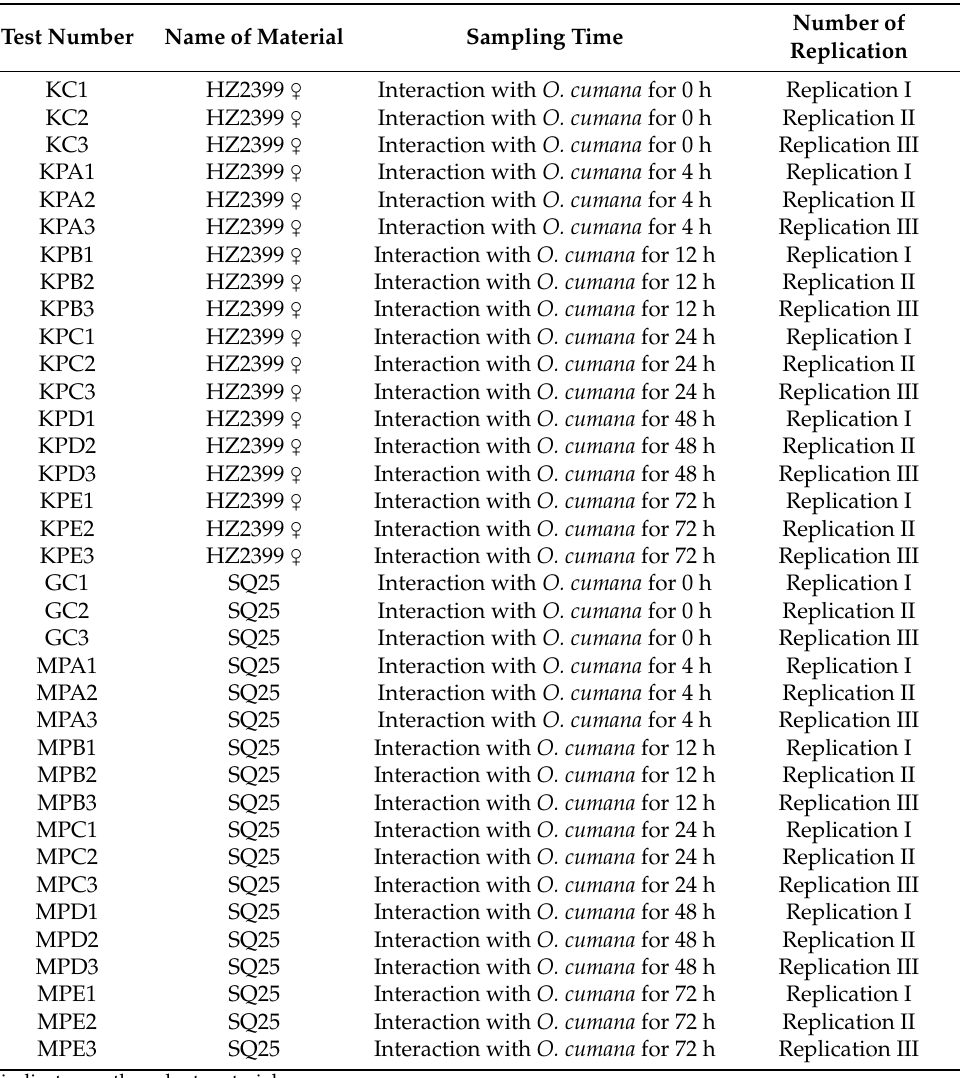
Table 1. Sample list of